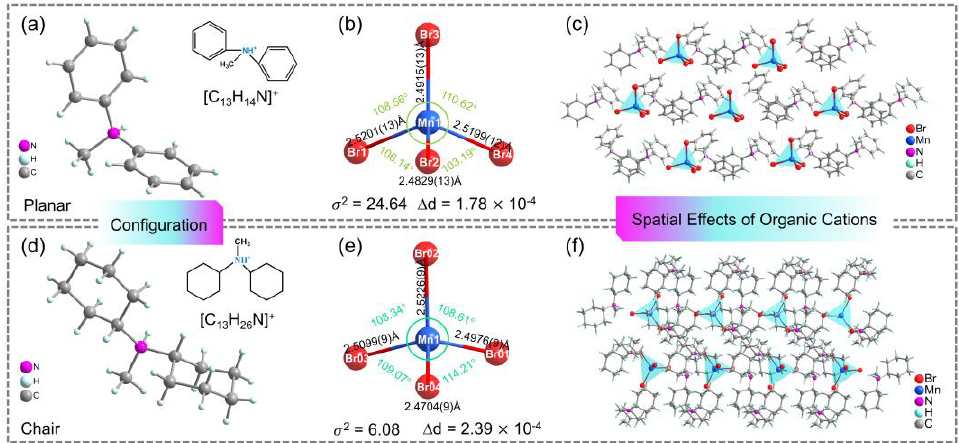
Figure 1. ( a , d ) The chemical structures of organic cations [C 13 H 14 N] + and [C 13 H 26 N] + . ( b , e ) Ball and stick models of inorganic units and structural information including bond length, bond angles and twist degrees. ( c , f ) Crystal structures of (C 13 H 14 N) 2 MnBr 4 and (C 13 H 26 N) 2 MnBr 4 . The phase purity and crystallinity of (C 13 H 14 N) 2 MnBr 4 and (C 13 H 26 N) 2 MnBr 4 powders were monitored by PXRD, and the results are shown in Figure S1. All peaks were indexed by triclinic cell ( P 1) and monoclinic cell ( P 2 1 / c ) with parameters close to those obtained from a single crystal experiment, respectively. Therefore, these structures were considered as a starting model for Rietveld refinement, as shown in Figure 2a,b, which were performed using TOPAS 4.2. The refinement results were stable and gave low R-factors. The main parameters of processing and refinement of (C 13 H 14 N) 2 MnBr 4 and (C 13 H 26 N) 2 MnBr 4 were listed in Table S3. The elemental mapping images (Figure 2c,d) indicate that the elements N, Br and Mn are evenly distributed on the above manganese bromides.